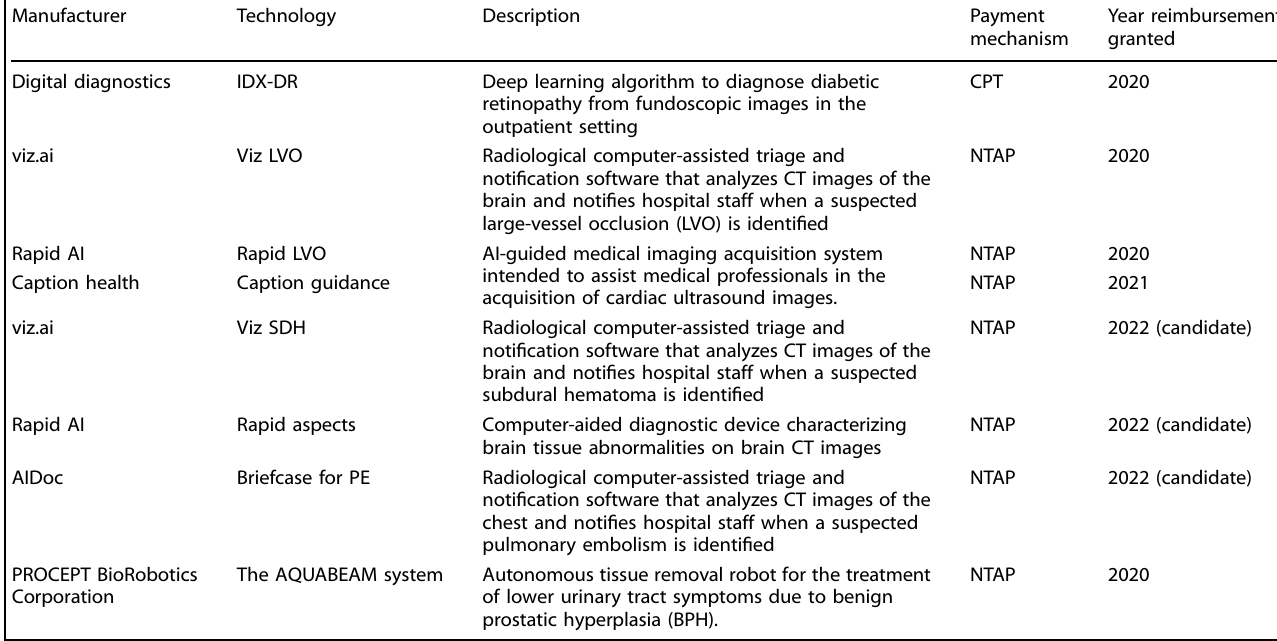
Table 1. Selected AI devices that are reimbursed by US